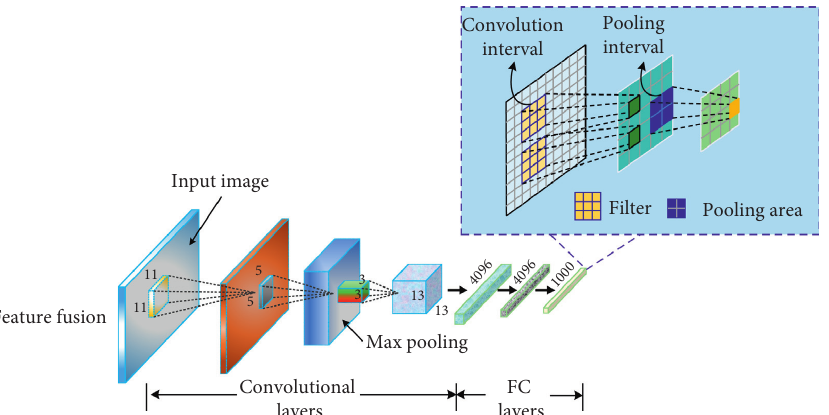
Figure 1: The structure of convolution neural network.